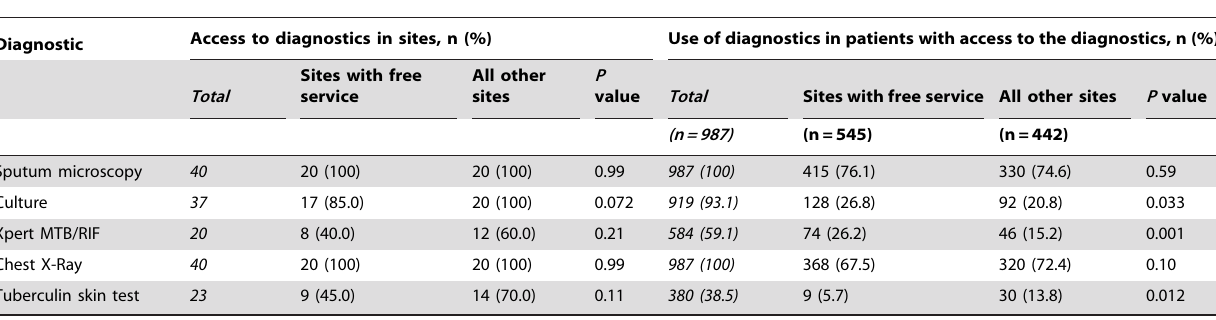
Table 4. Availability and use of tuberculosis (TB) diagnostics in HIV-infected individuals, comparing sites with a cost model of free services to the patients and all other sites with full payment, cost sharing or any other cost model.